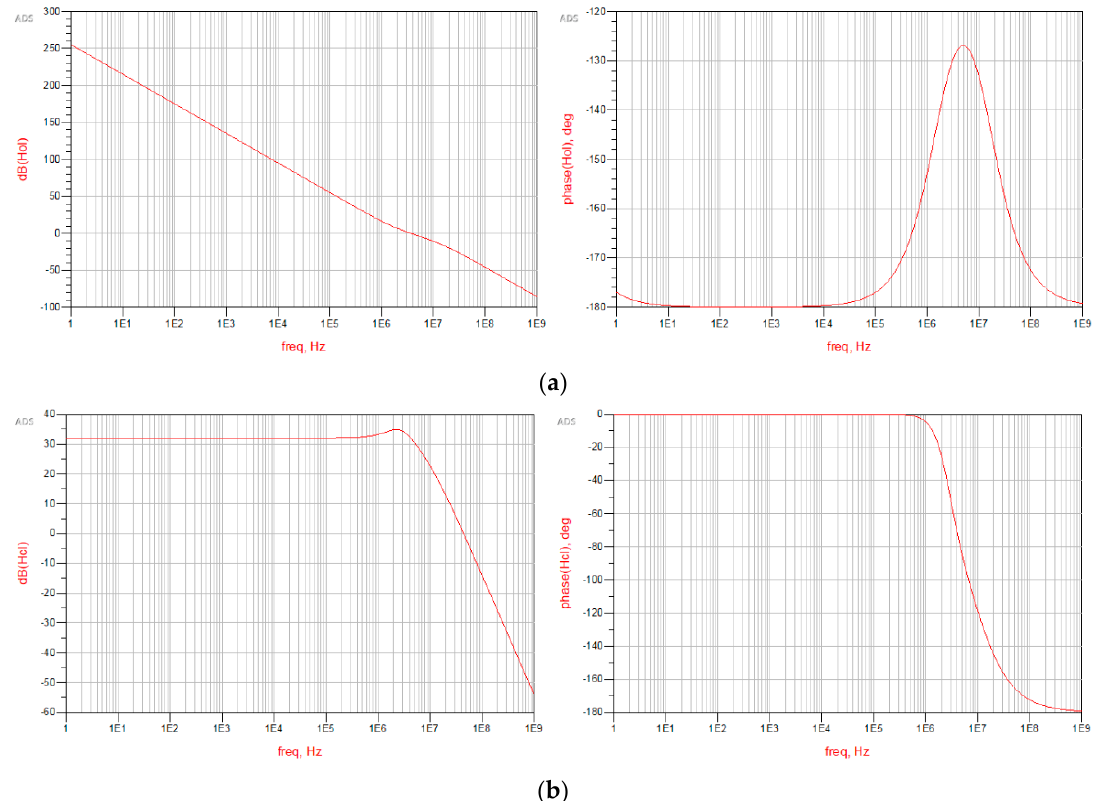
Figure 3. Results of the AC analysis performed on the phase domain models: magnitude on the left and phase on the right of ( a ) the open loop model and ( b ) the closed loop model.